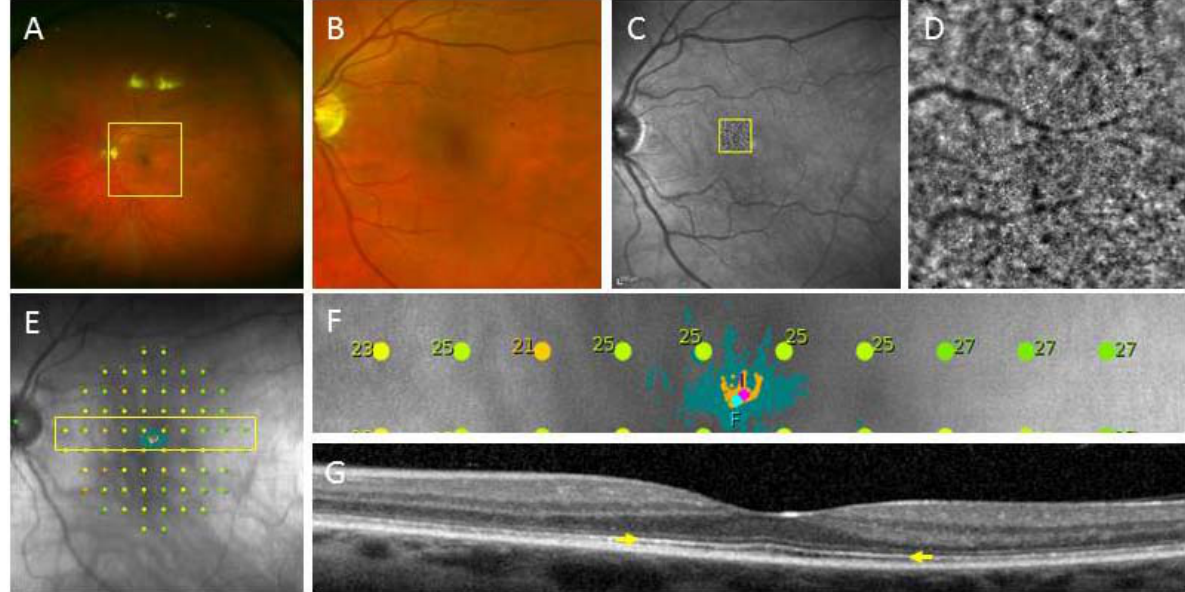
Figure 1. An example of high-resolution retinal images from a patient with hydroxychloroquine toxicity. ( A ) Wide-field colour photography; ( B ) Zoomed-in colour image highlighted by the yellow box in ( A ) of the macular region showing no obvious abnormality; ( C ) Near-infrared reflectance image of the macula showing no obvious abnormality; ( D ) Adaptive optics retinal image highlighted by the yellow box in ( C ) showing the loss of wave-guiding cone outer segments in the perifoveal region; ( E ) Microperimetry showing reduced sensitivity to light in the macular region; ( F ) Zoomed-in image of the perifoveal region showing reduced sensitivity (<25 dB is abnormal); ( G ) Corresponding optical coherence tomography through the fovea showing no obvious loss of the ellipsoid zone of the photoreceptors (yellow